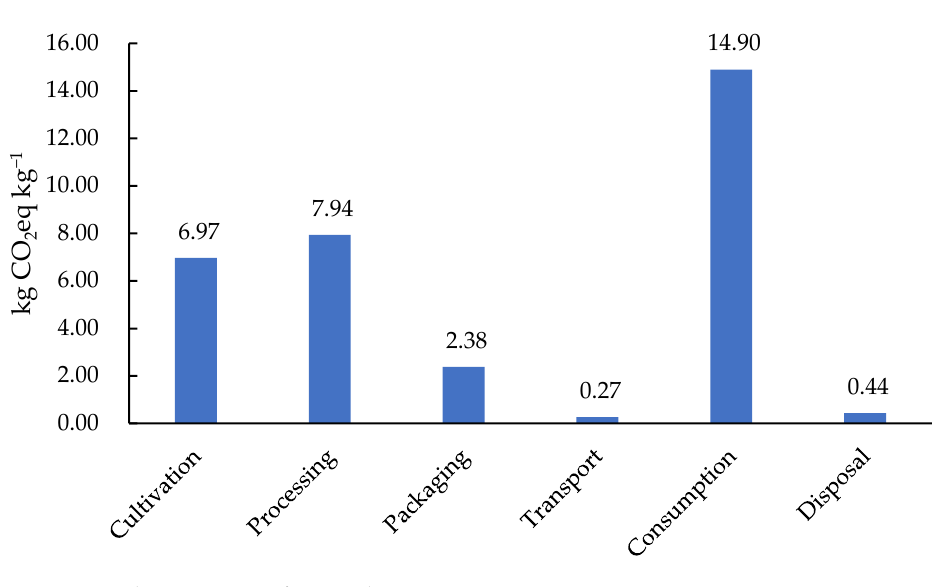
Figure 3. Carbon emissions from each stage.